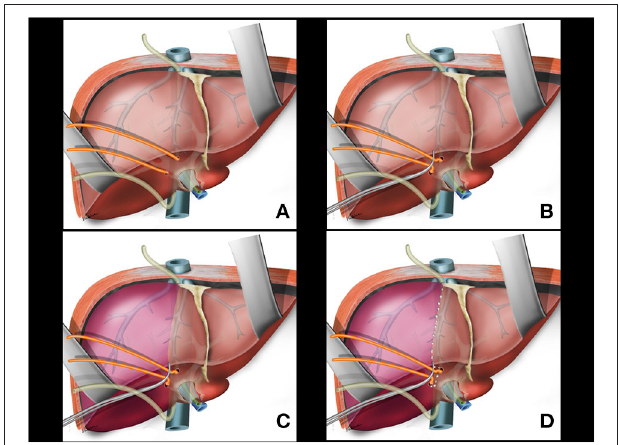
FIGURE 4 | (A) Partial transection of liver parenchyma between the caudate lobe and the right posterior sector; the nasogastric tube of the liver hanging manouver is fitted in this space (arrow). (B) The nasogastric tube used in the hanging maneuver is brought to the anterior aspect of the right glissonian pedicle (arrow). (C) During parenchymal transection, upwards traction is applied on the nosogastric tube (arrows). (D) Main right pedicle without liver tissue around it. Anterior aspect of retrohepatic vena cava is